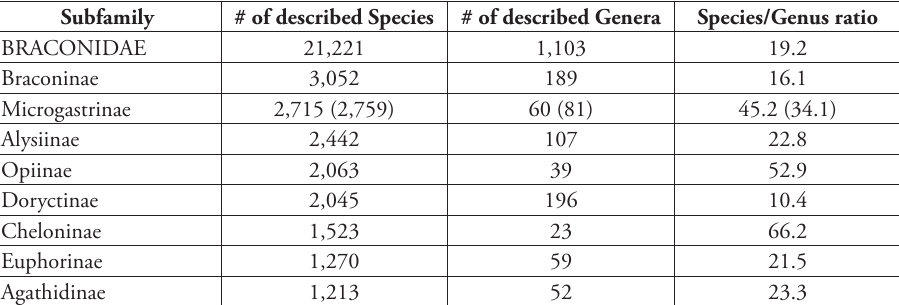
Table 1. Diversity of species and genera of the family Braconidae and its eight most diverse subfamilies. To provide a fair comparison all data is based on the same source (Yu et al. 2016), even though numbers for some groups have slightly changed for the past two years. For Microgastrinae, the values between parentheses include the new data from the present